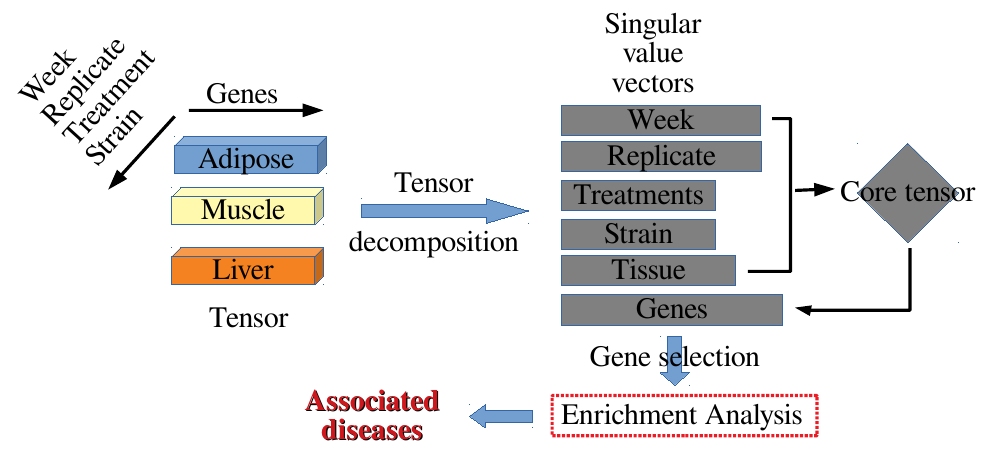
Figure 1. Overall flowchart of the analysis pipeline.